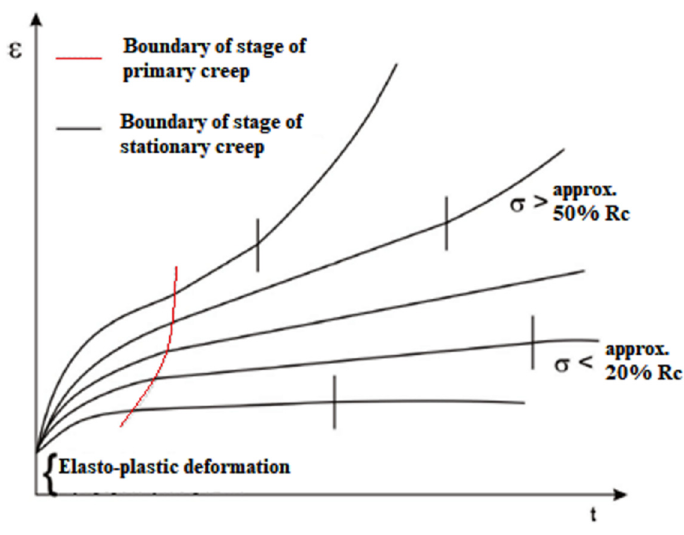
Figure 3. Deformation phases of salt rock [17].